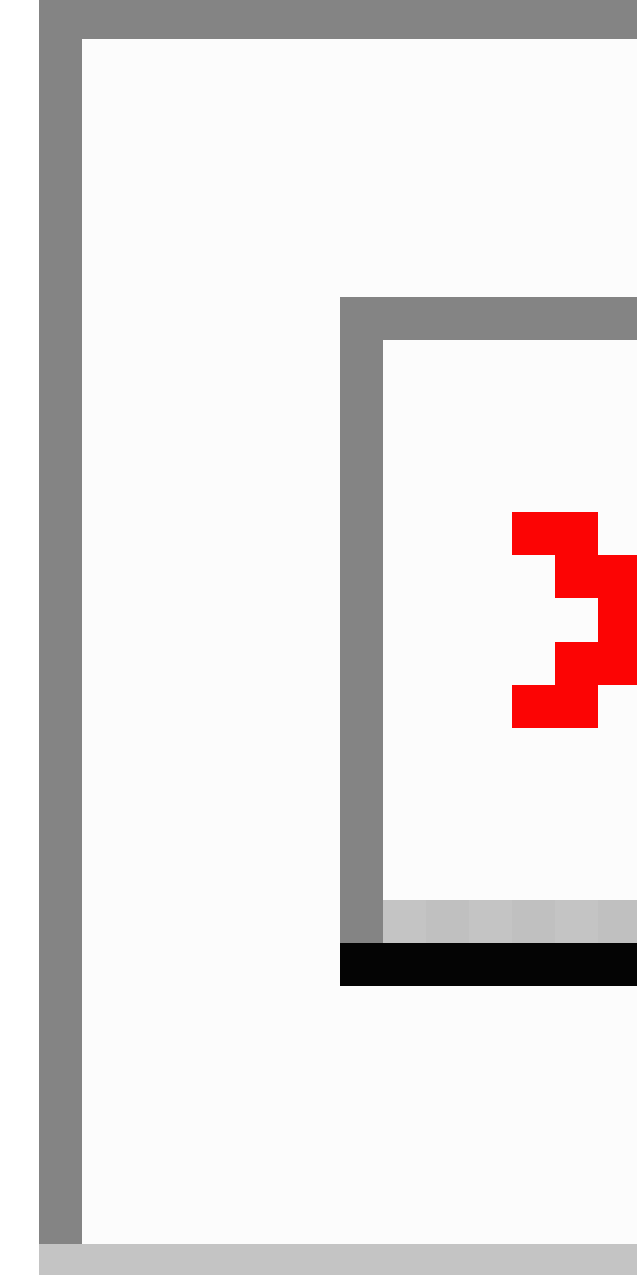
Figure 3. Overall risk of bias analysis of included